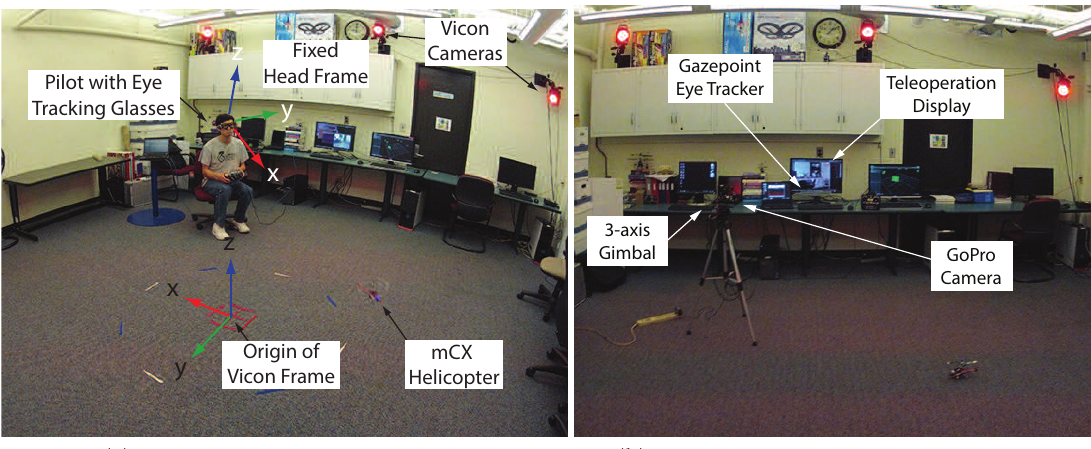
Figure 5. Overview pictures showing the lab setup for flight experiments with the pilot ( a ) directly observing the rotorcraft ( b ) operating in a teleoperation